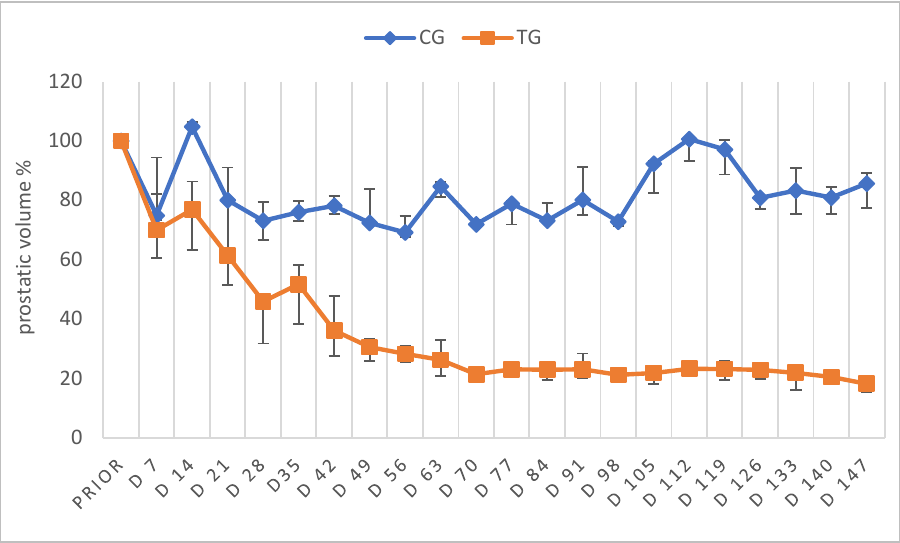
Figure 3. Prostatic volume given in % as median (Q1, Q3) over time of animals treated with a 4.7 mg deslorelin implant (TG, n = 7) and saline-treated control animals (CG, n = 3). “Prior” indicates “prior to treatment”.